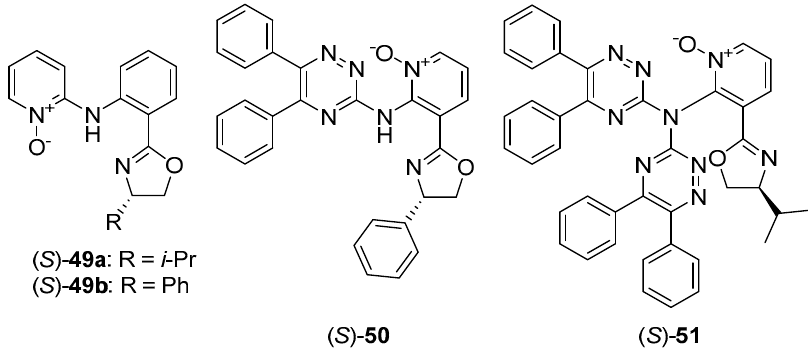
Figure 10. N- oxide ligands used in Cu-catalyzed nitroaldol reaction. Figure 10. N -oxide ligands used in Cu-catalyzed nitroaldol